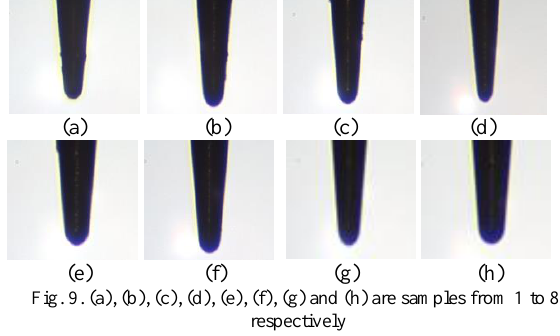
Fig. 9. (a), (b), (c), (d), (e), (f), (g) and (h) are samples from 1 to 8,